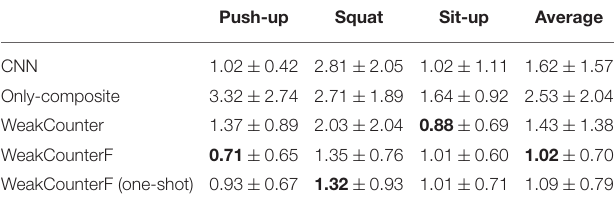
TABLE 3 | MAE of each method for each type of workout.